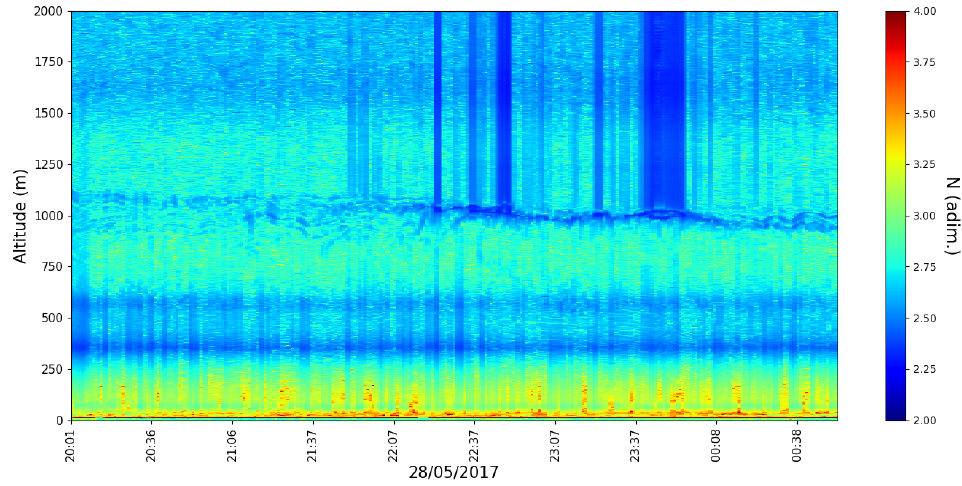
Figure 16. 𝑁 profile timeseries, profiling rate 1/min, 28 April 2017.